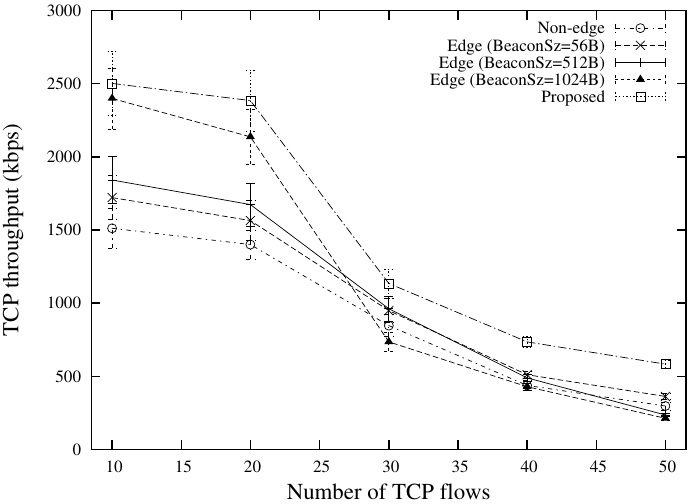
Figure 12. TCP throughput for various numbers of flows (the case of 400 m source-destination